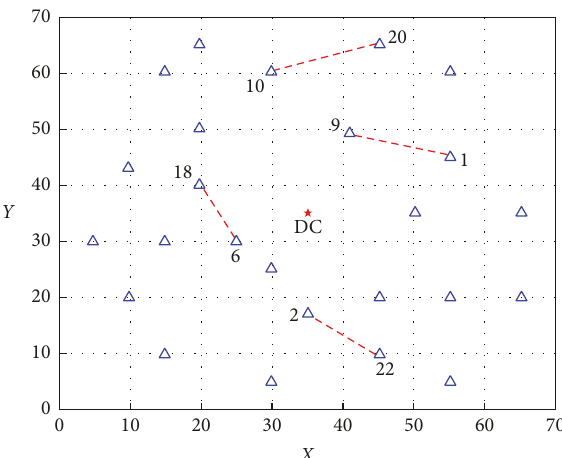
Figure 2: Locations of the distribution centre and